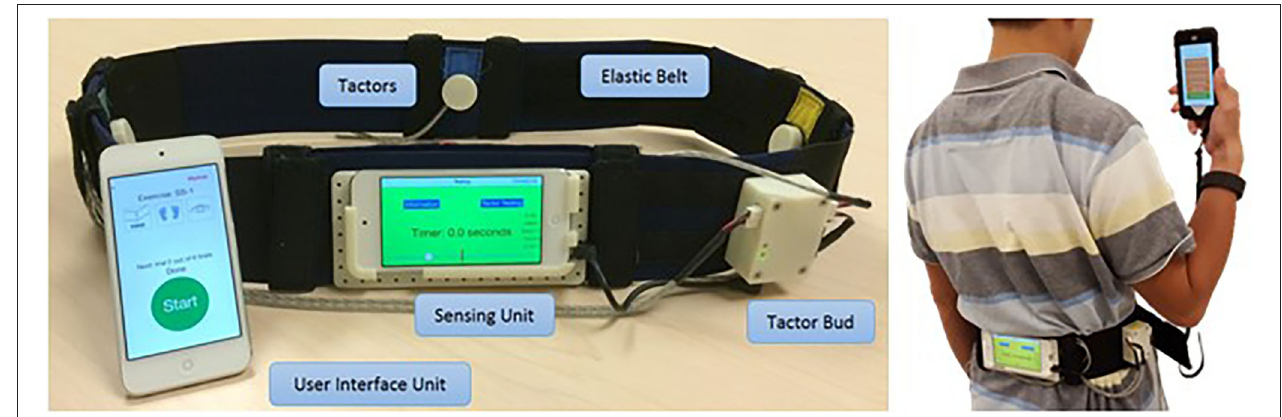
FIGURE 1 | Vibrotactile stimulation devices. The smartphone-based balance trainer used in Bao et al. (2018). The sensing unit is attached to an elastic belt worn around the torso to measure trunk sway. The four tactors are aligned over the anterior, posterior, and right and left sides of the torso to provide directional vibrotactile